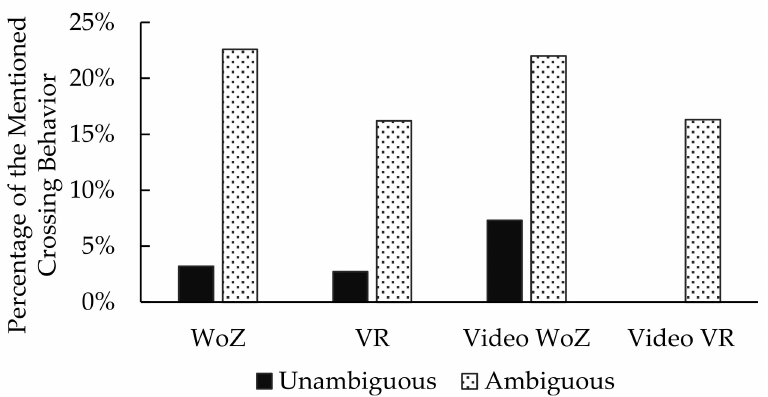
Figure 7. Mentioned crossing behavior for the intention AV goes first , for the participants who misunderstood the